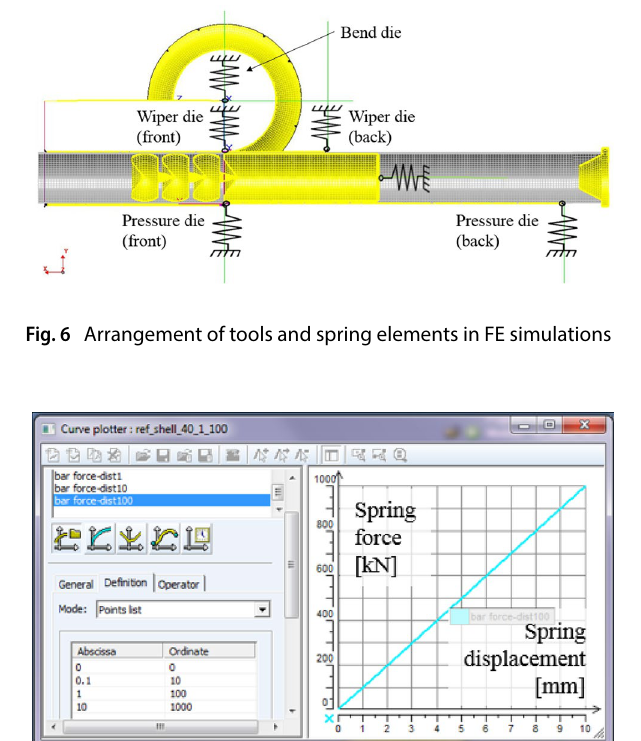
Fig. 7 Entering the spring rate in Pam Stamp Professional 2019.0